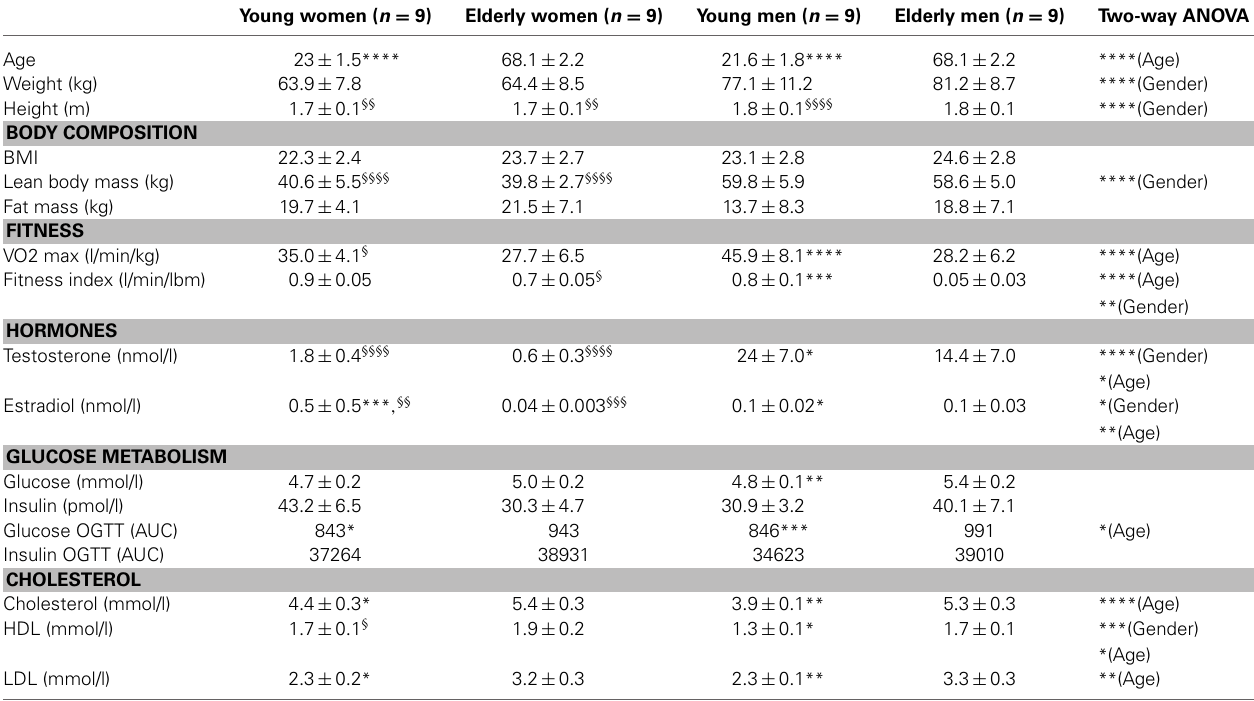
Table 1 | In vivo study